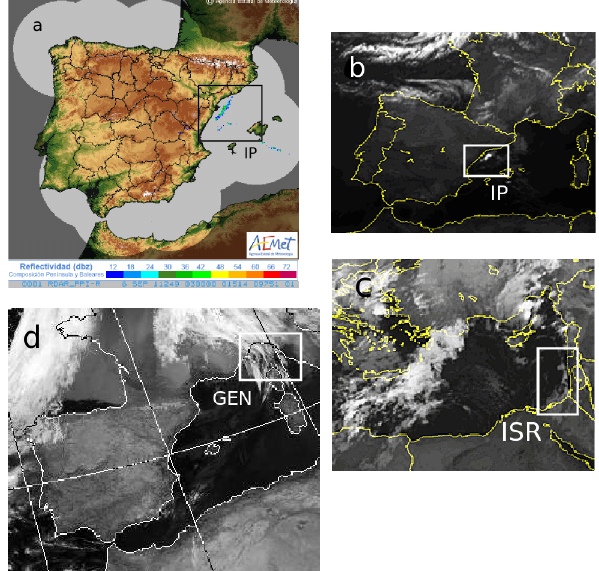
Figure 3. Data recorded from (a) the reflectivity radar image at 03:00UTC on 6 September 2011, (b) the Meteosat satellite in the IR channel at 03:00UTC on 11 September 2011 for the IP event, (c) the Meteosat satellite in the IR channel at 03:00UTC on 6 Jan- uary 2011 for the ISR event, and (d) NOAA-18 in the thermal IR channel at 02:32UTC on 30 January 2008 for the GEN event. The white rectangles indicate the approximate locations of the domains used in the WRF simulations.